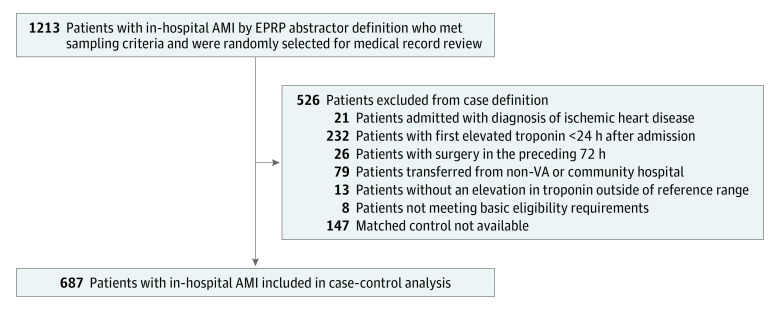
Selection of In-Hospital Acute Myocardial Infarction (AMI) CasesEPRP indicates External Peer Review Program; VA, Veterans Affairs.